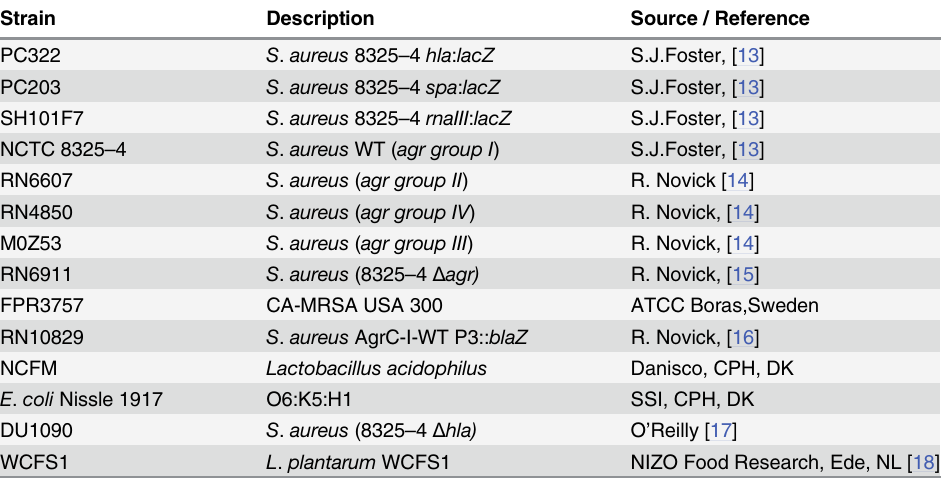
Table 1. Strains and their